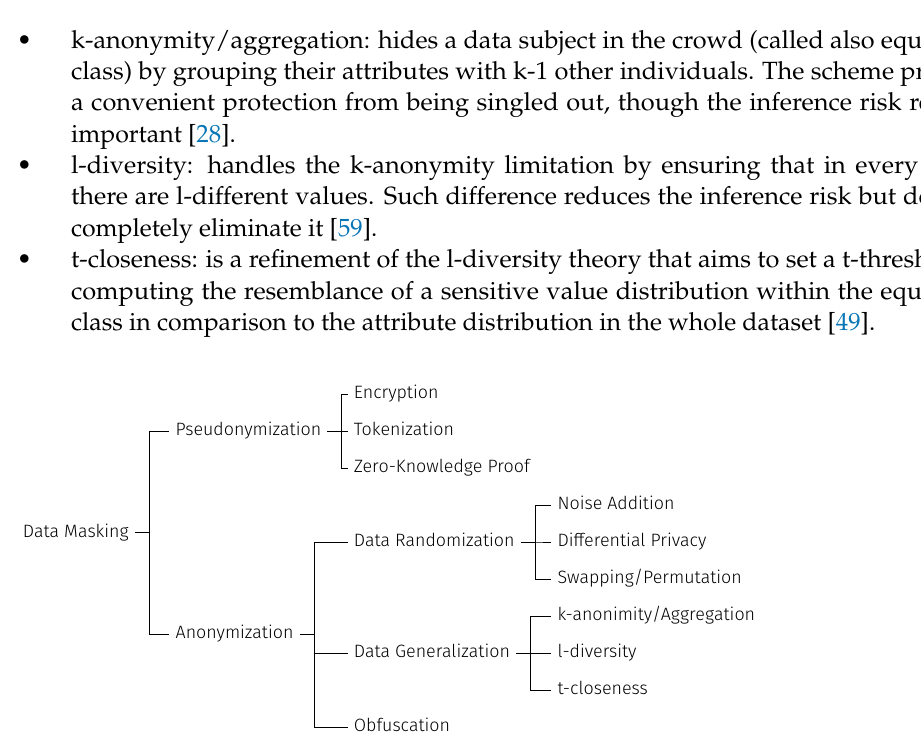
Figure 4. Classification of privacy-preserving